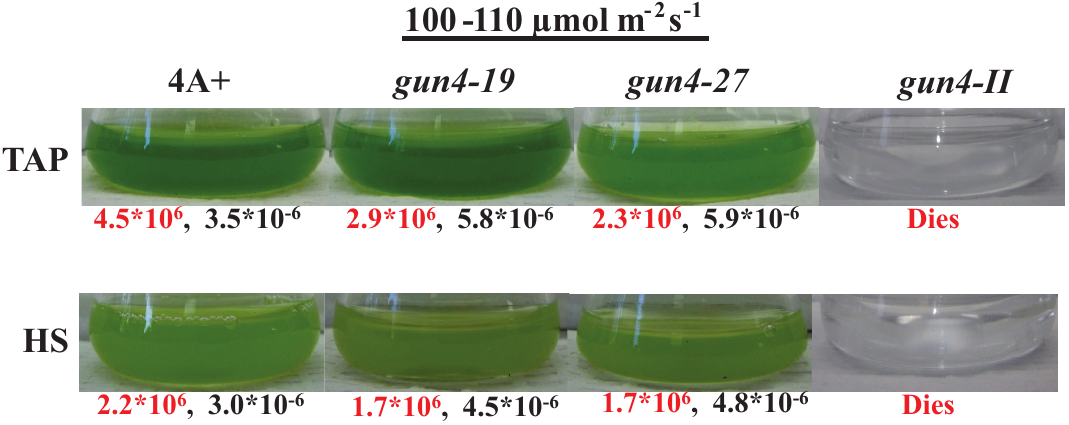
Figure 10. Mixotrophic and photo-autotrophic growth of gun4-II complements. Light intensity is labeled above the culture flask. Growth media is labeled to the left of the culture flask. The mean cell density (cells/ml) and the Chlorophyll (Chl) content (nmol Chl per cell) are shown below the culture flasks in red and black numbers, respectively. For each light condition and growth condition, experiments were performed on three biological replicates of each strain. Statistical error (±SD) was ≤